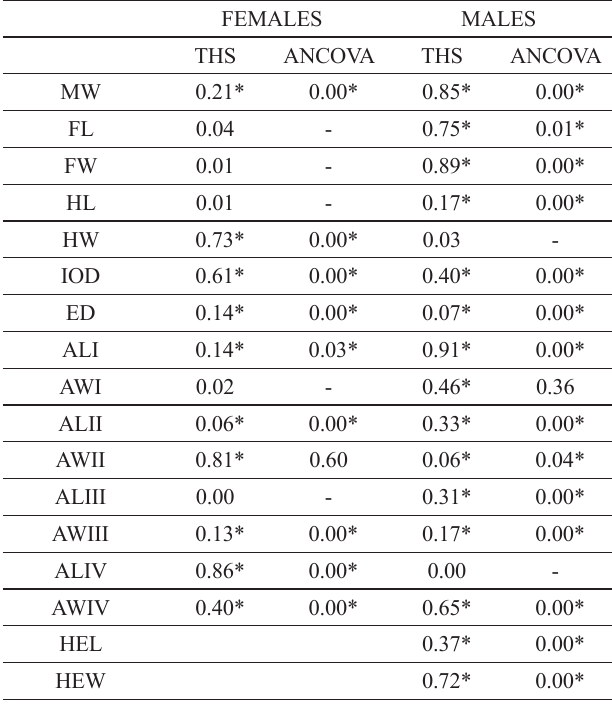
Summary of the morphometric analysis of Lolliguncula brevis collected off